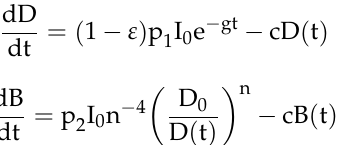
Table 3. The variables and the parameters of our new model (along with their units).